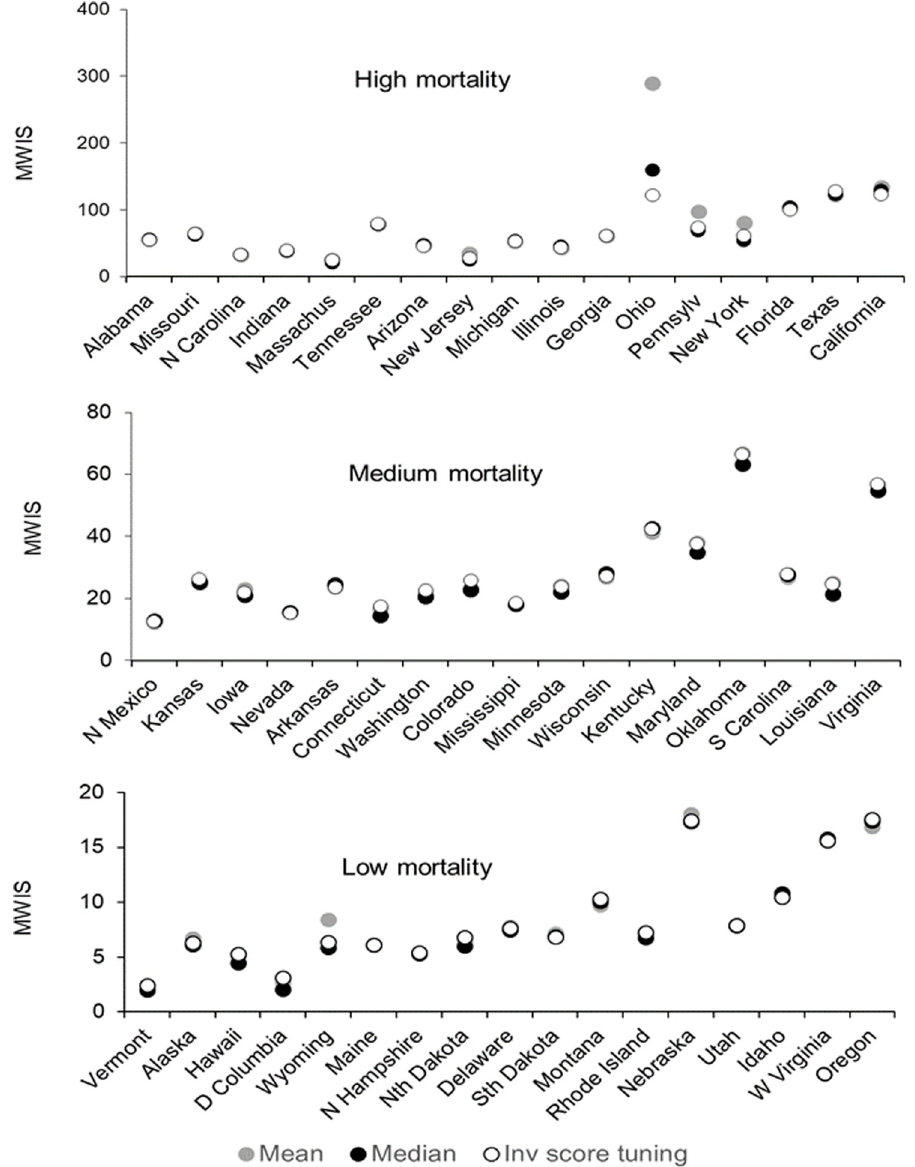
Fig 7. For incident mortality, MWIS for high, medium and low mortality states for three selected combining